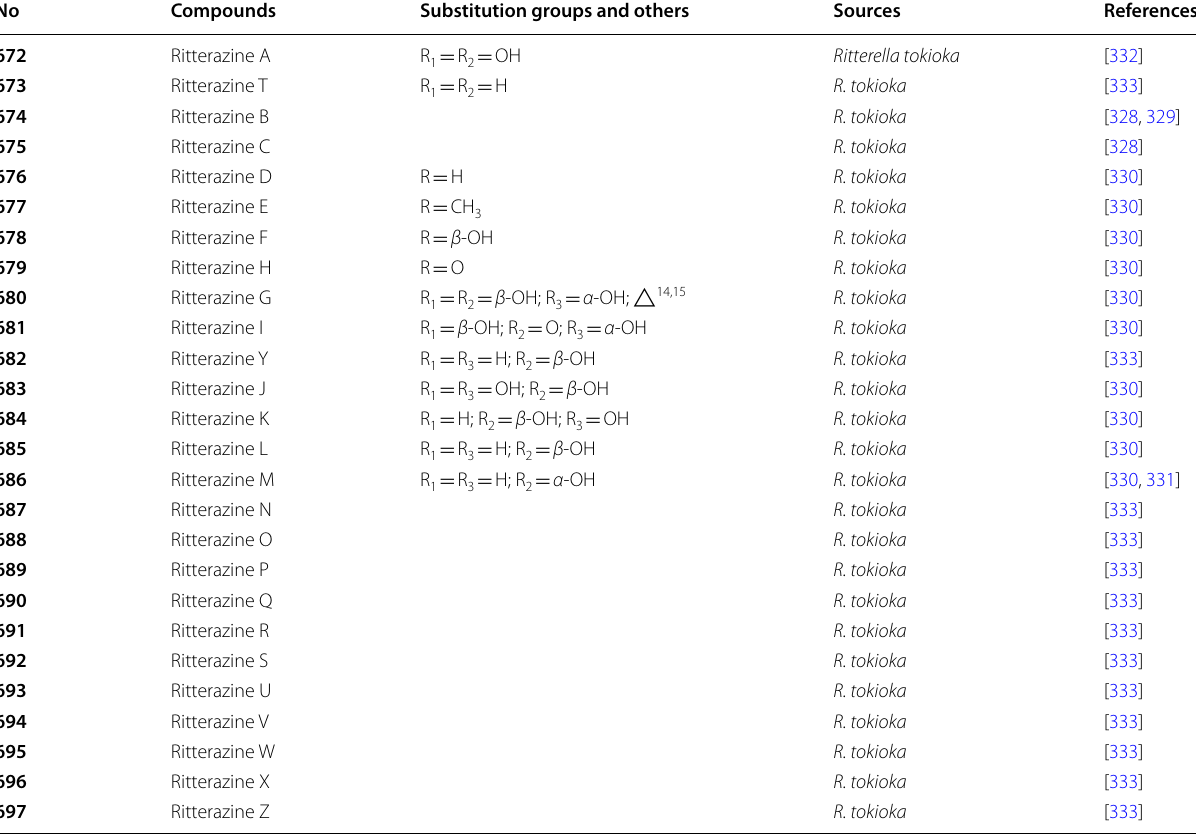
Table 17 Structures and sources of ritterazines 672–697 No Compounds Substitution groups and